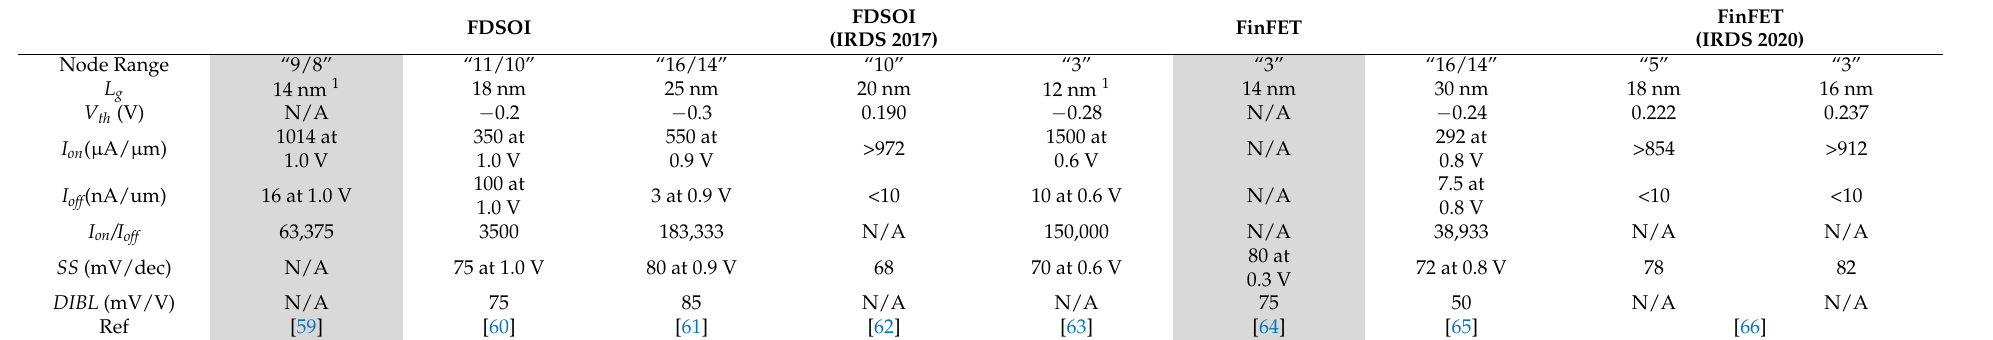
Table 6. Comparison of different gate-length FDSOI and FinFET